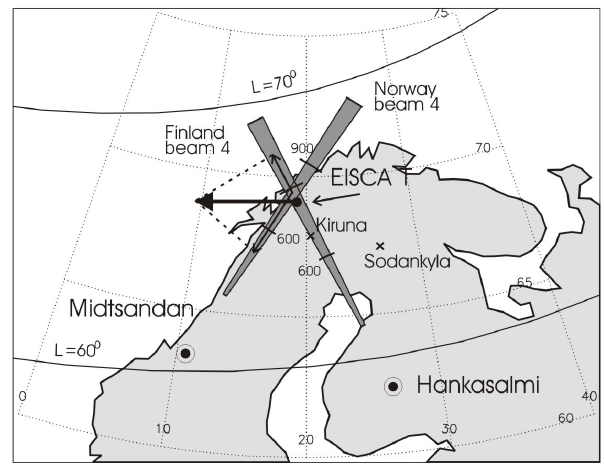
Fig. 1. Field of view of the Hankasalmi Finland STARE radar beam 4 and the Midtsandan Norway STARE radar beam 4 assum- ing 110-km height of backscatter. The short curved lines across the beams are slant range marks at 600 and 900km. In the standard mode mapping the STARE irregularity drift velocity vector, V irr , is the cosine-merged product of the two measured velocities, V N V F . The solid dot denotes the area where ionospheric parameters irr were measured by the EISCAT incoherent scatter facility, which in- cludes a UHF transmitter/receiver at Tromso and receivers at Kiruna and Sodankyla (crosses). The solid thick lines indicate PACE (Polar Anglo-American conjugate experiment) magnetic